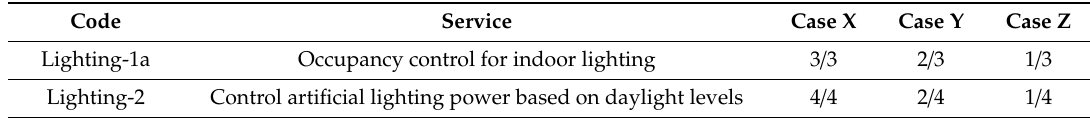
Table 7. The functionality levels in the main domain of lighting.